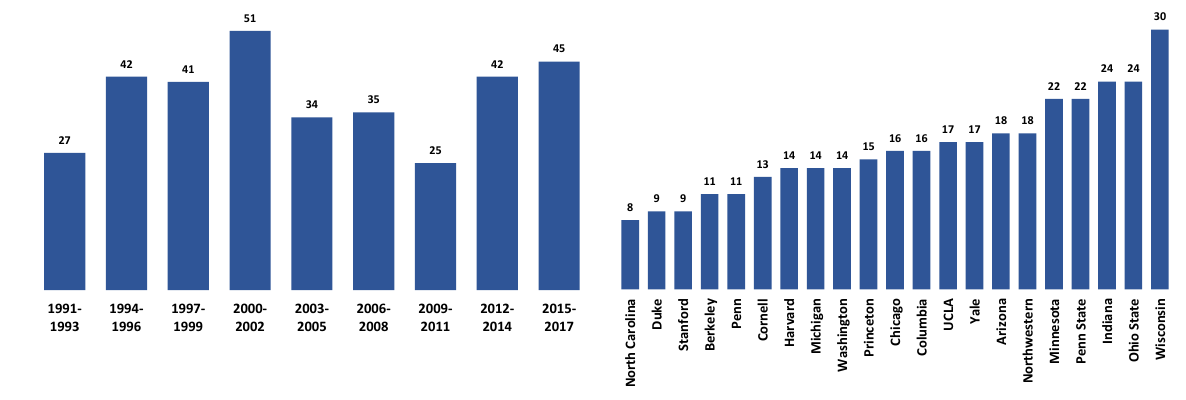
Figure 1: Number of new assistant professors by year and